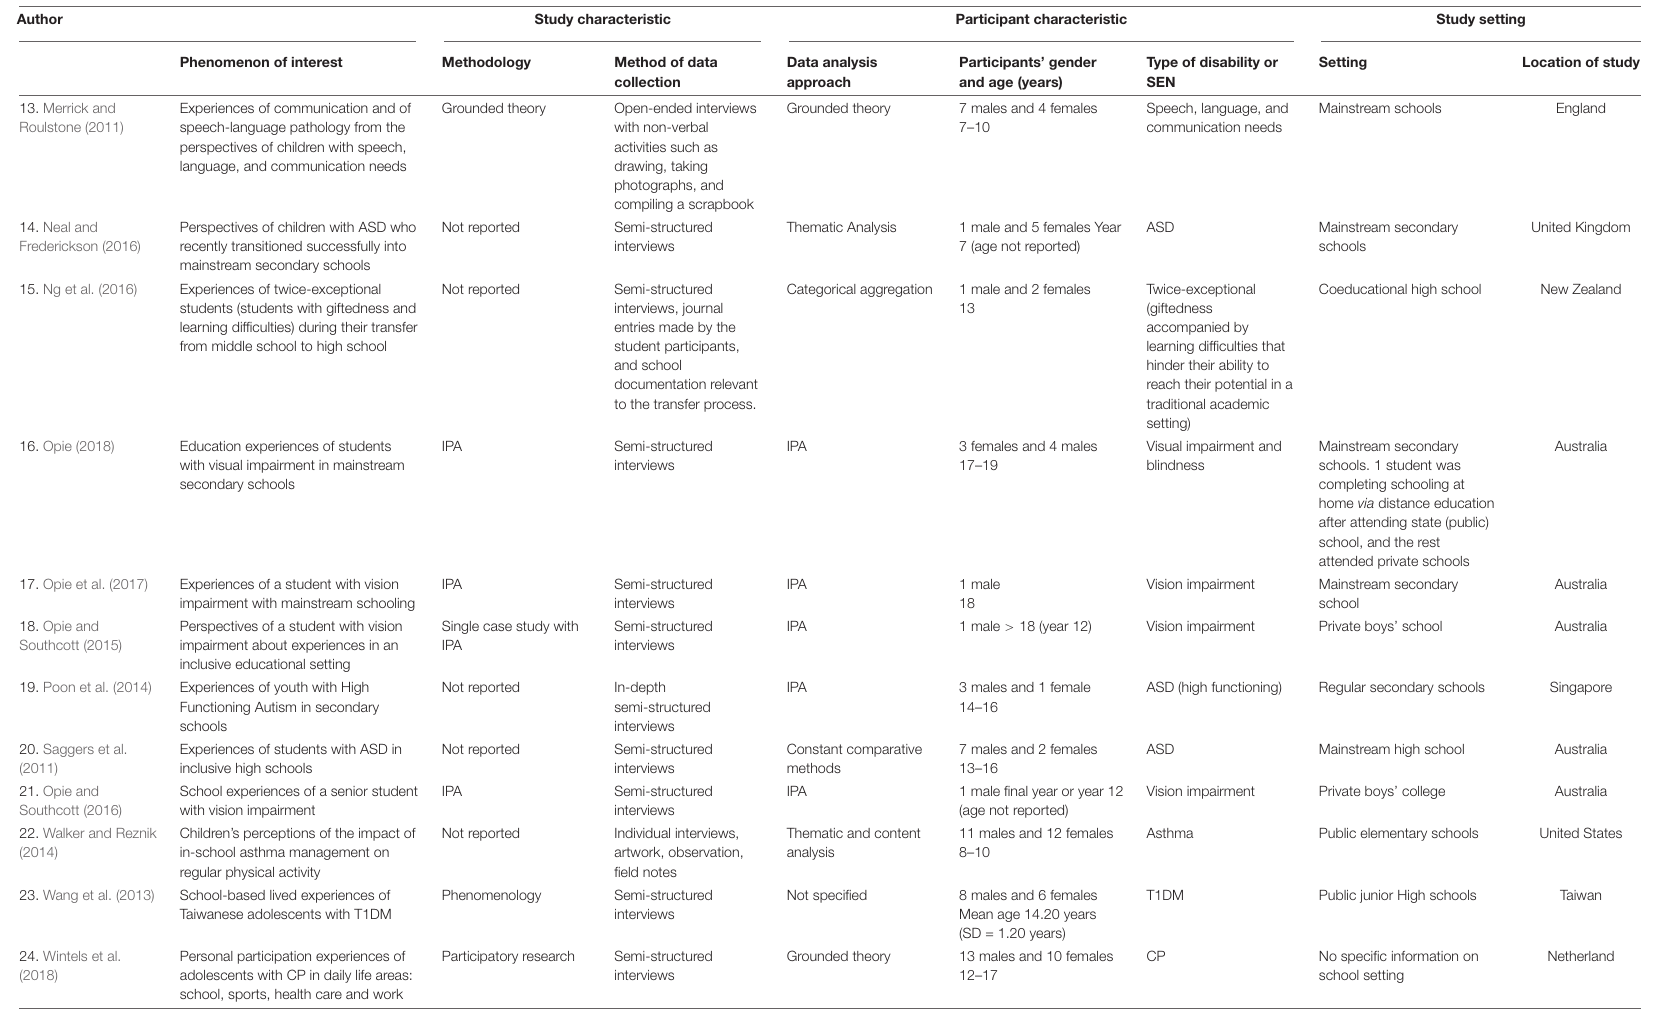
TABLE 3 | Main characteristics of the studies selected for data extraction and synthesis.